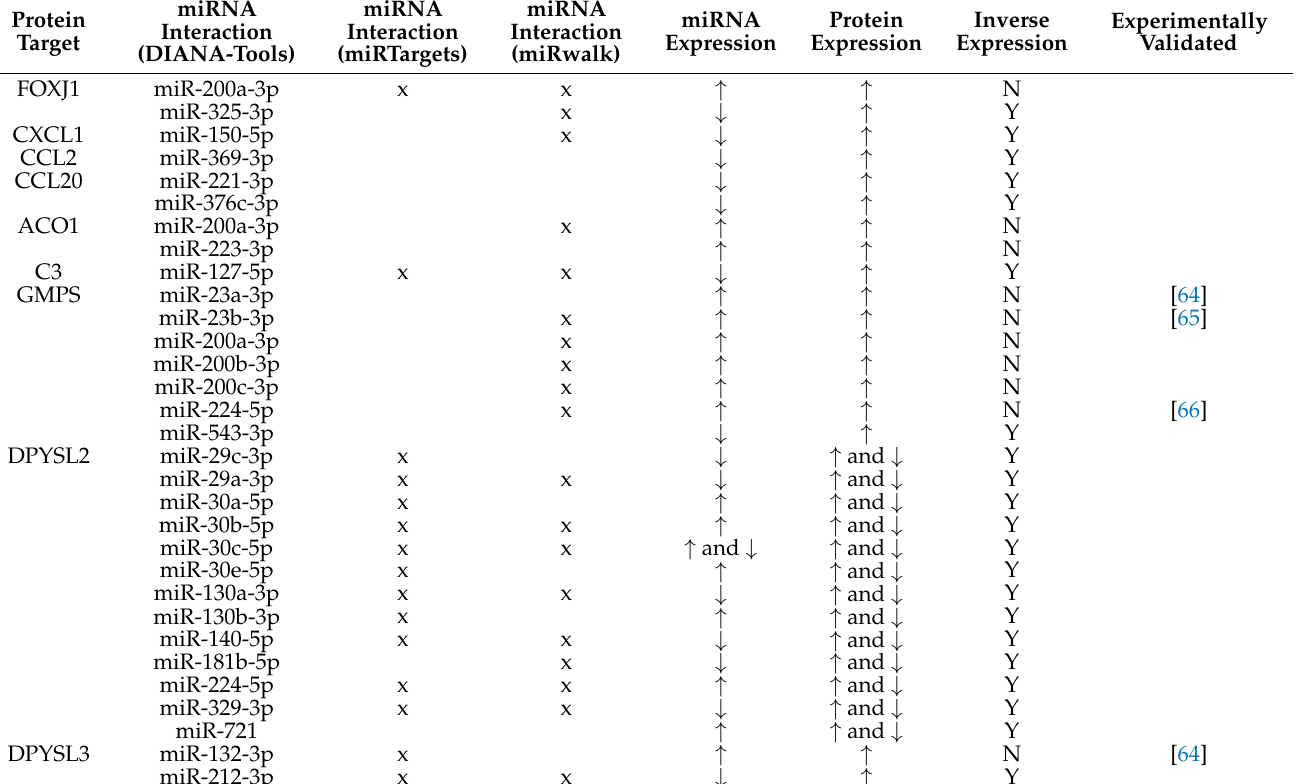
Table 3. miRNA-protein interactions predicted by DIANA tools and confirmed by miRtaregts and miRwalk tools. The ta- ble also reports the inverse expression relationships between miRNAs and proteins and whether the interaction was experimentally